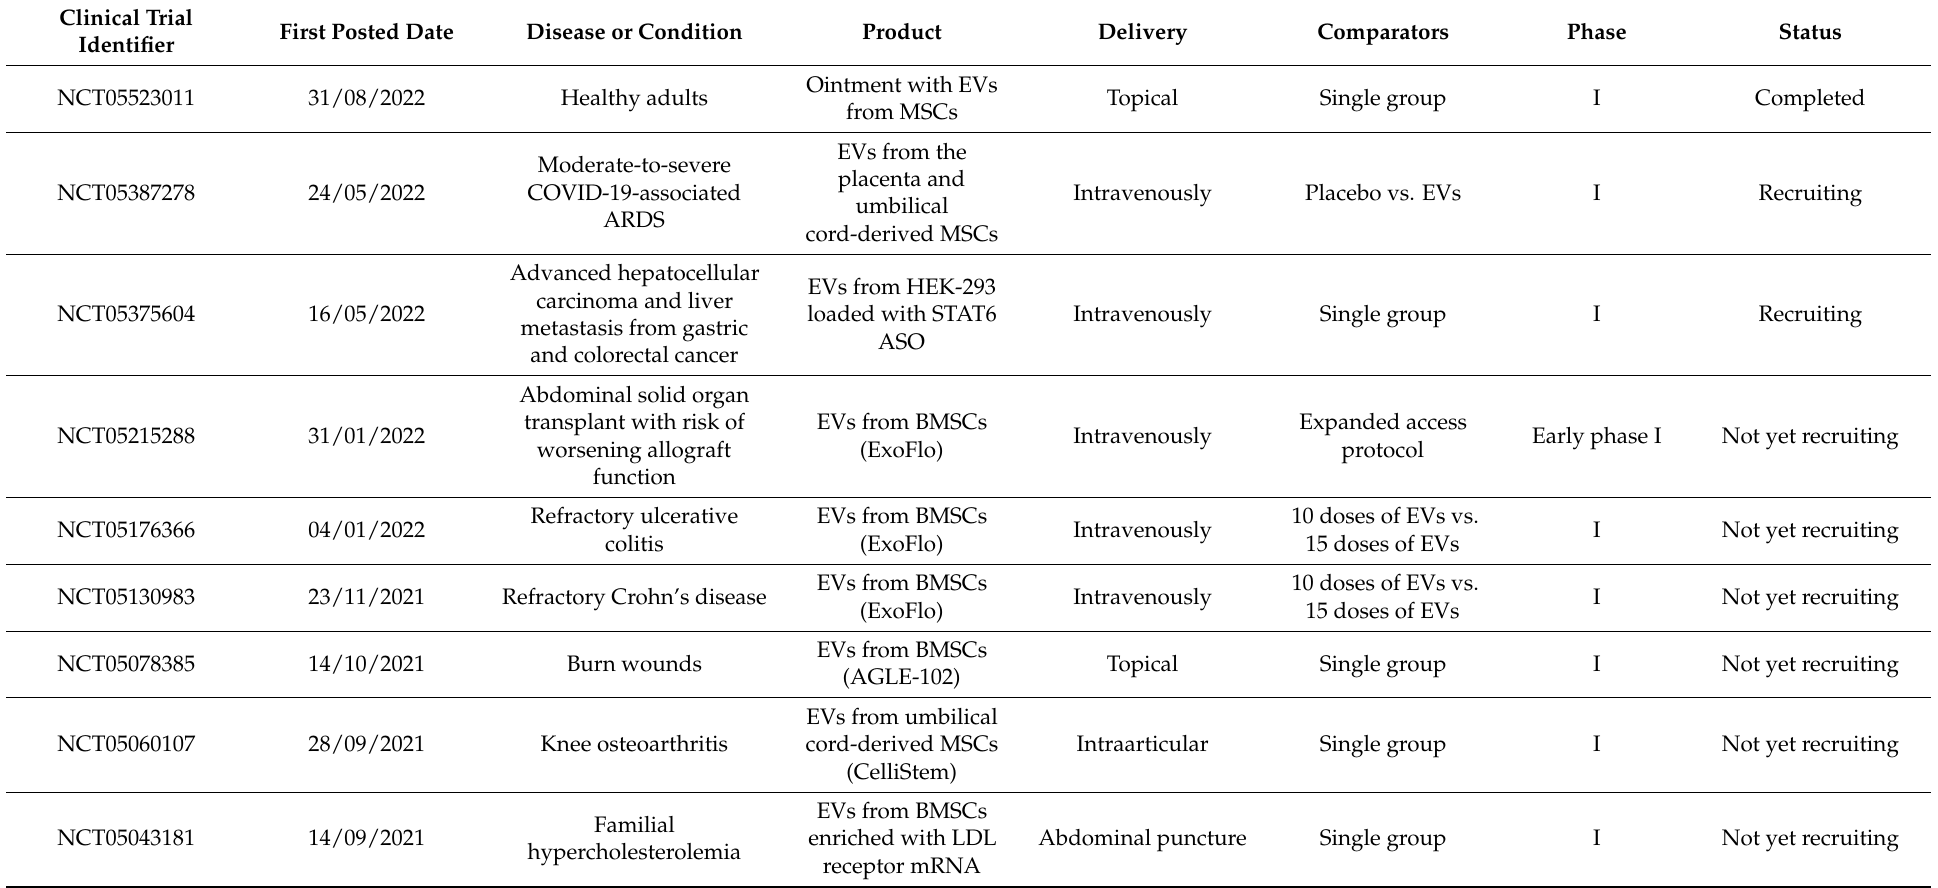
Table 1. Registered clinical trials (clinicaltrials.gov) related to therapy with extracellular vesicles (extracellular vesicles/exosomes/microvesicles search) as the main intervention. ADSCs: Adipose-derived stem cells; ARDS: acute respiratory distress syndrome; ASO: anti-sense oligonucleotide; BMSCs: Bone marrow-derived stem